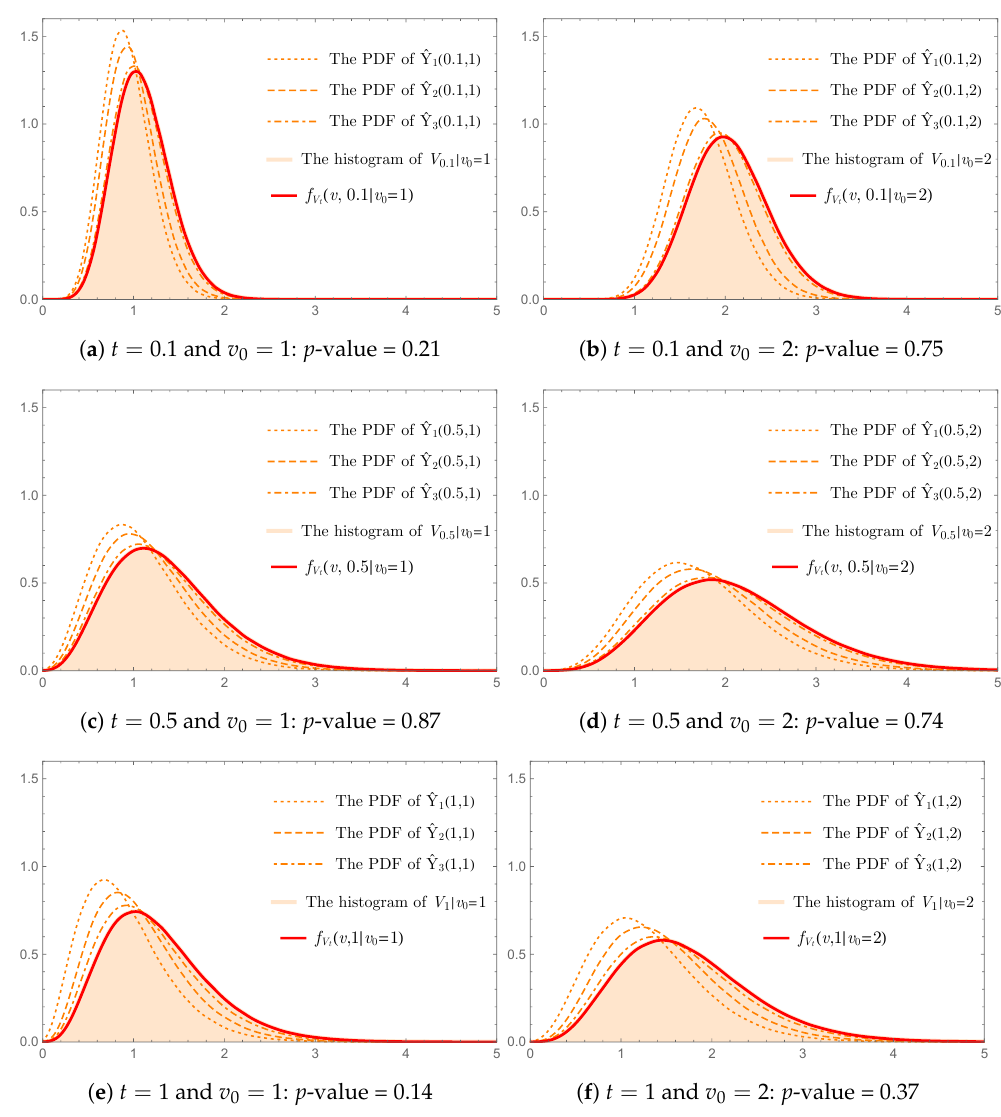
Figure 8. The convergence of ˆ Y n ( t , v 0 ) = ∑ n ˆ α i ˆ X i in distribution to V t | v 0 as n approaches infinity i = 1 tested by using MC simulations in Example 3, demonstrating the result (22) presented in Theorem 10, ( v , t | v ) computed by using our explicit Formula (31). against f V 0 t